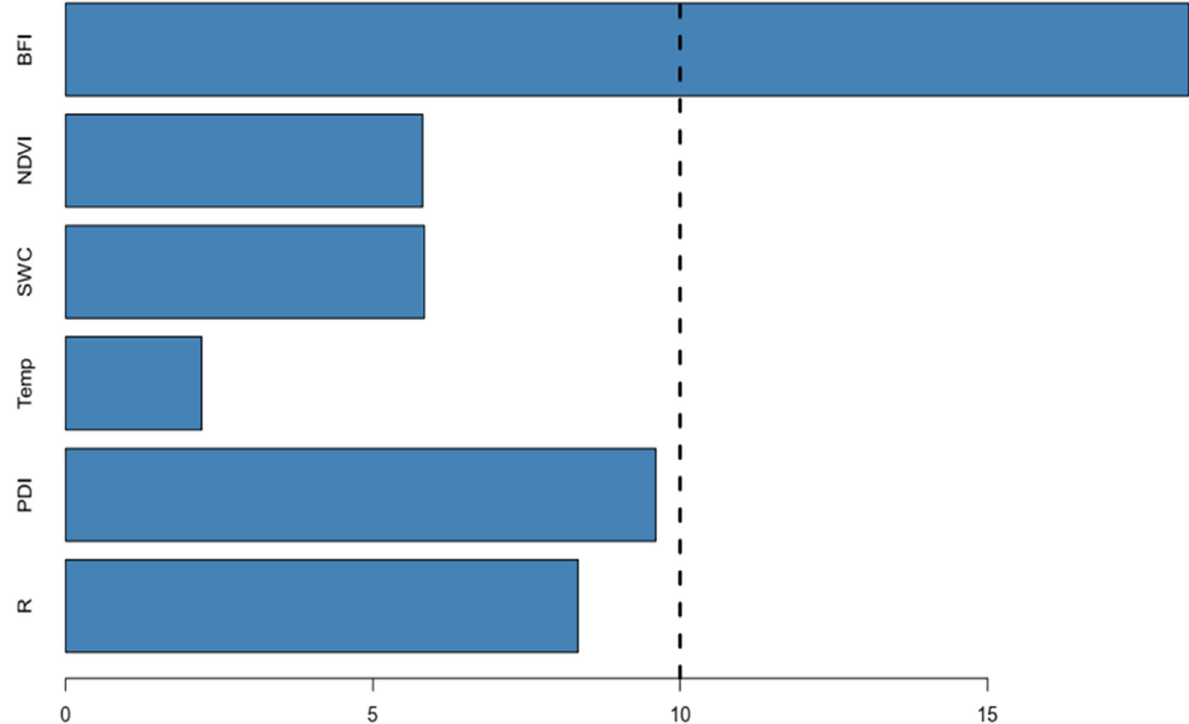
Fig. 3 VIF values of explanatory variables for the full regression model